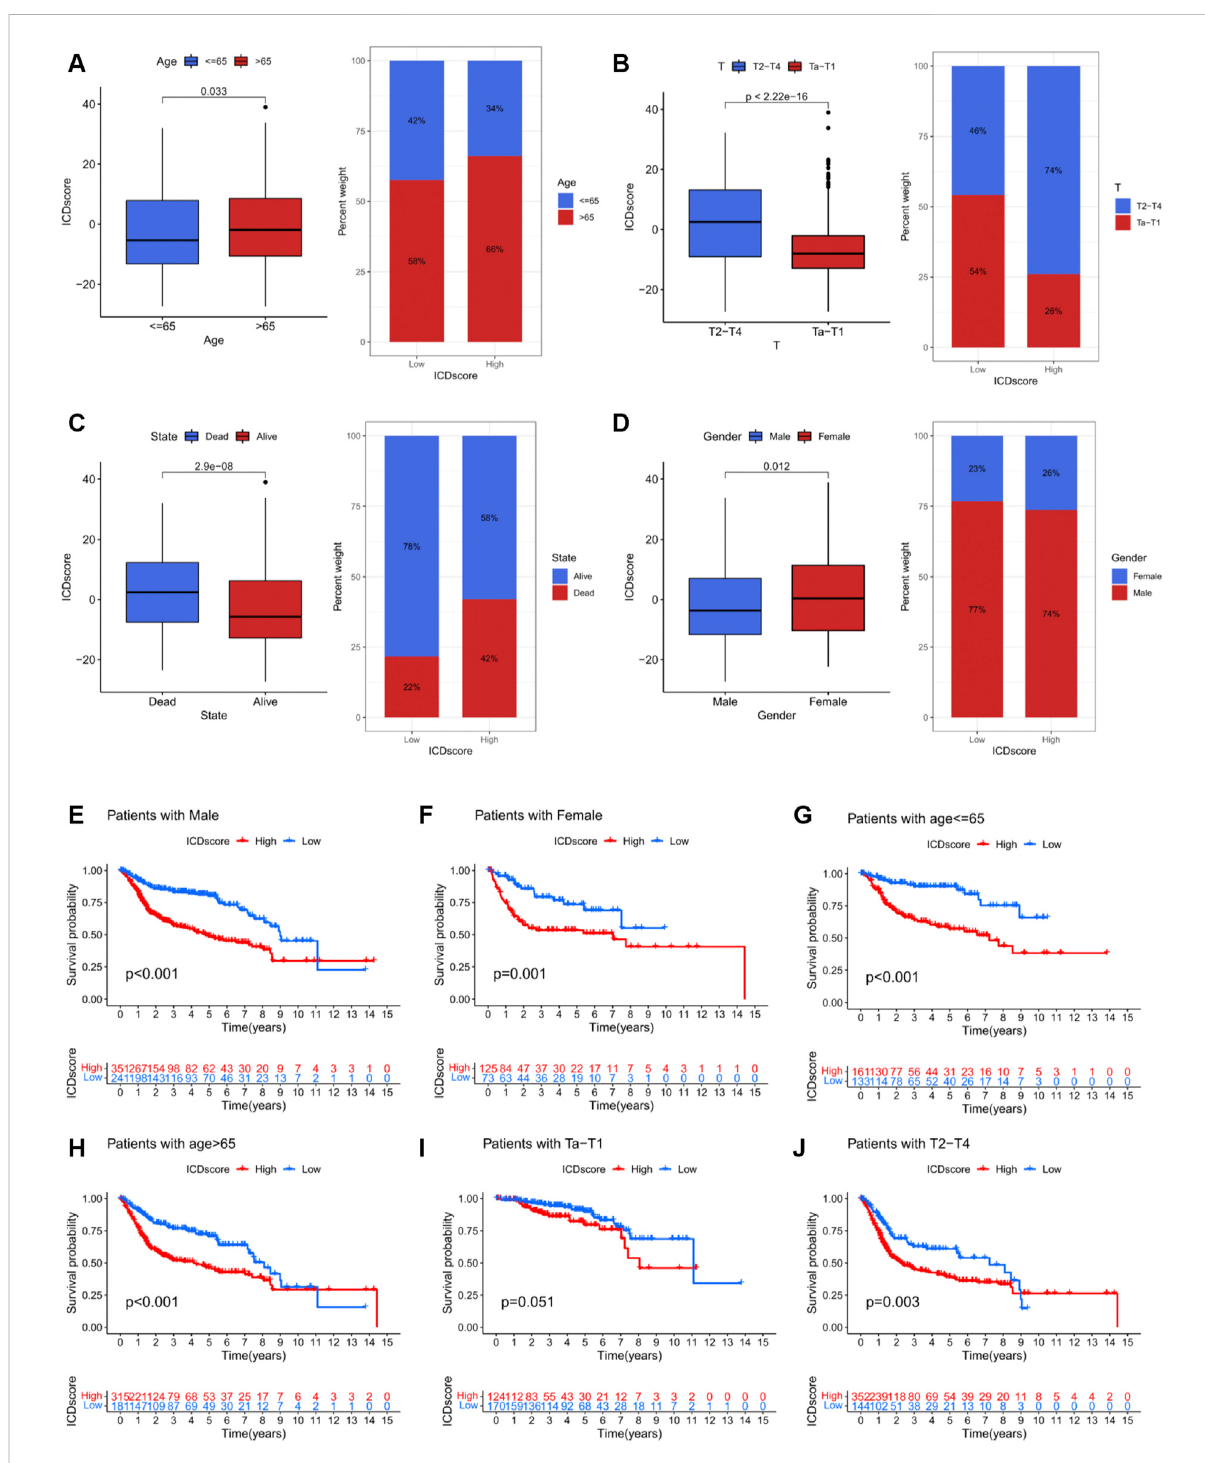
FIGURE 7 Relationship between ICD score and different clinical parameters and Kaplan – Meier survival analysis of different ICD scores in different subgroups of the merged cohort. (A) Relationships between ICD score and age. (B) Relationship between ICD score and tumour T stage. (C) Relationship between ICD score and alive/dead status. (D) Relationship between ICD score and gender. (E) Kaplan – Meier survival analysis in male patients. (F) Kaplan – Meier survival analysis in female patients. (G) Kaplan – Meier survival analysis in patients aged ≤ 65 years. (H) Kaplan – Meier survival analysis in patients aged > 65 years. (I) Kaplan – Meier survival analysis in patients with Ta – T1 stage disease. (J) Kaplan – Meier survival analysis in patients with T2 – T4 stage